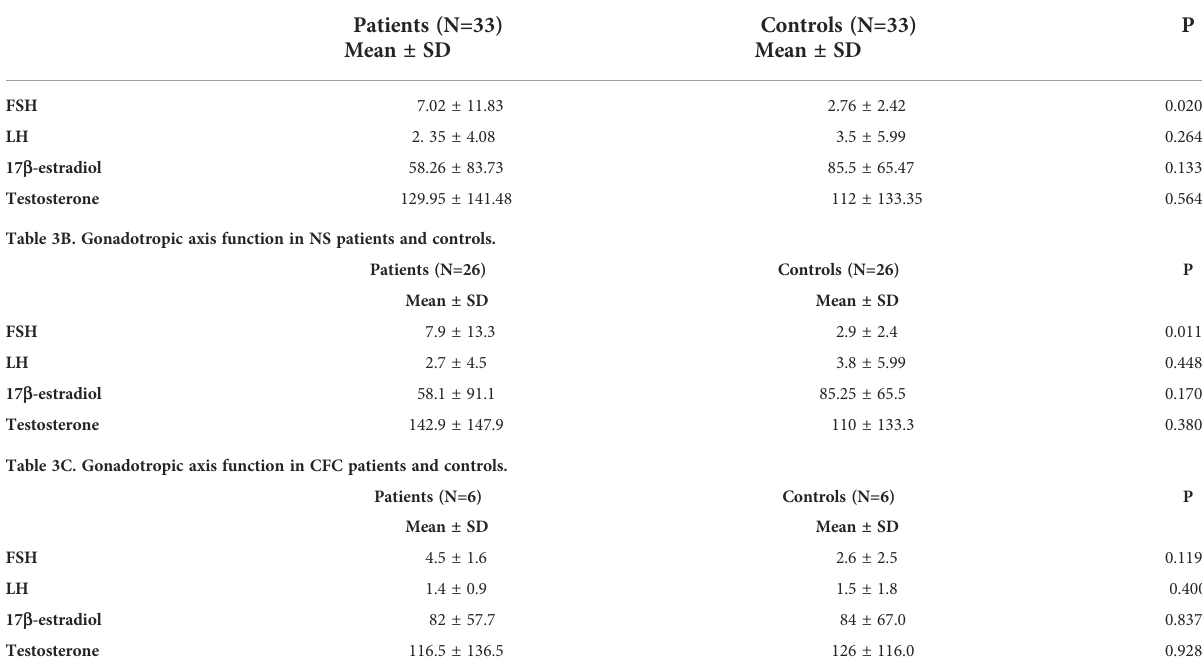
TABLE 3A Gonadotropic axis function in all patients and controls.